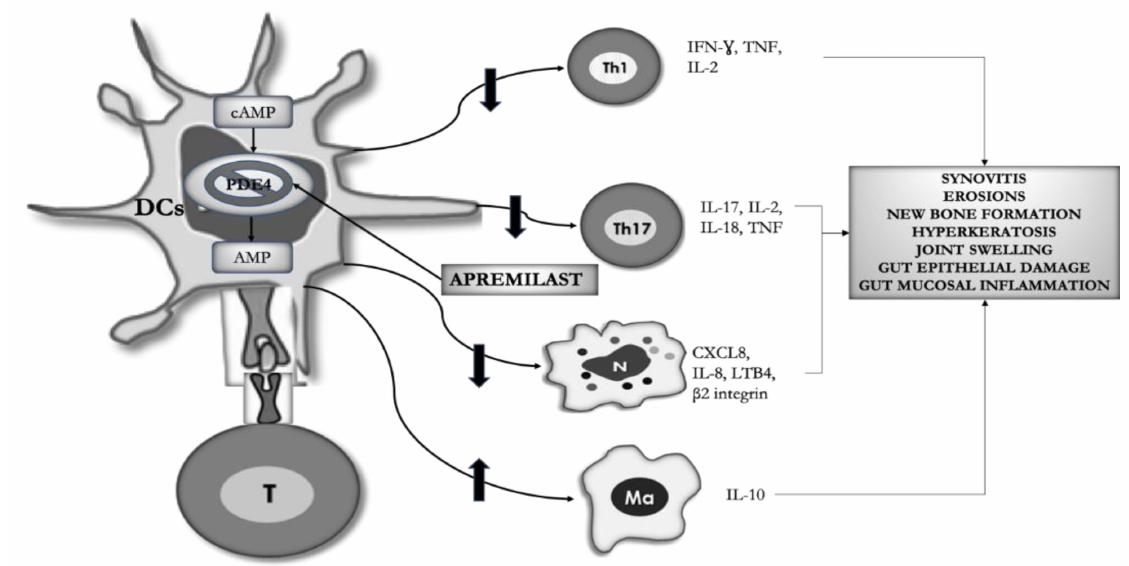
Figure 1. Immunologic rationale for PDE4 inhibition in psoriatic arthritis (PsA) and ulcerative colitis (UC). By blocking PDE4, apremilast increases the intracellular concentration of cAMP leading to an anti-inflammatory effect on different cell types of innate and adaptive immunity, involved in the pathogenesis of the characteristic features of psoriatic arthritis and ulcerative colitis. DCs = Dendritic cells, T = T cell, Th = T helper, IL= interleukin, IFN γ = interferon γ , Ma = macrophage, N = neutrophil, PDE4 = Phosphodiesterase4, cAMP = cyclic adenosine